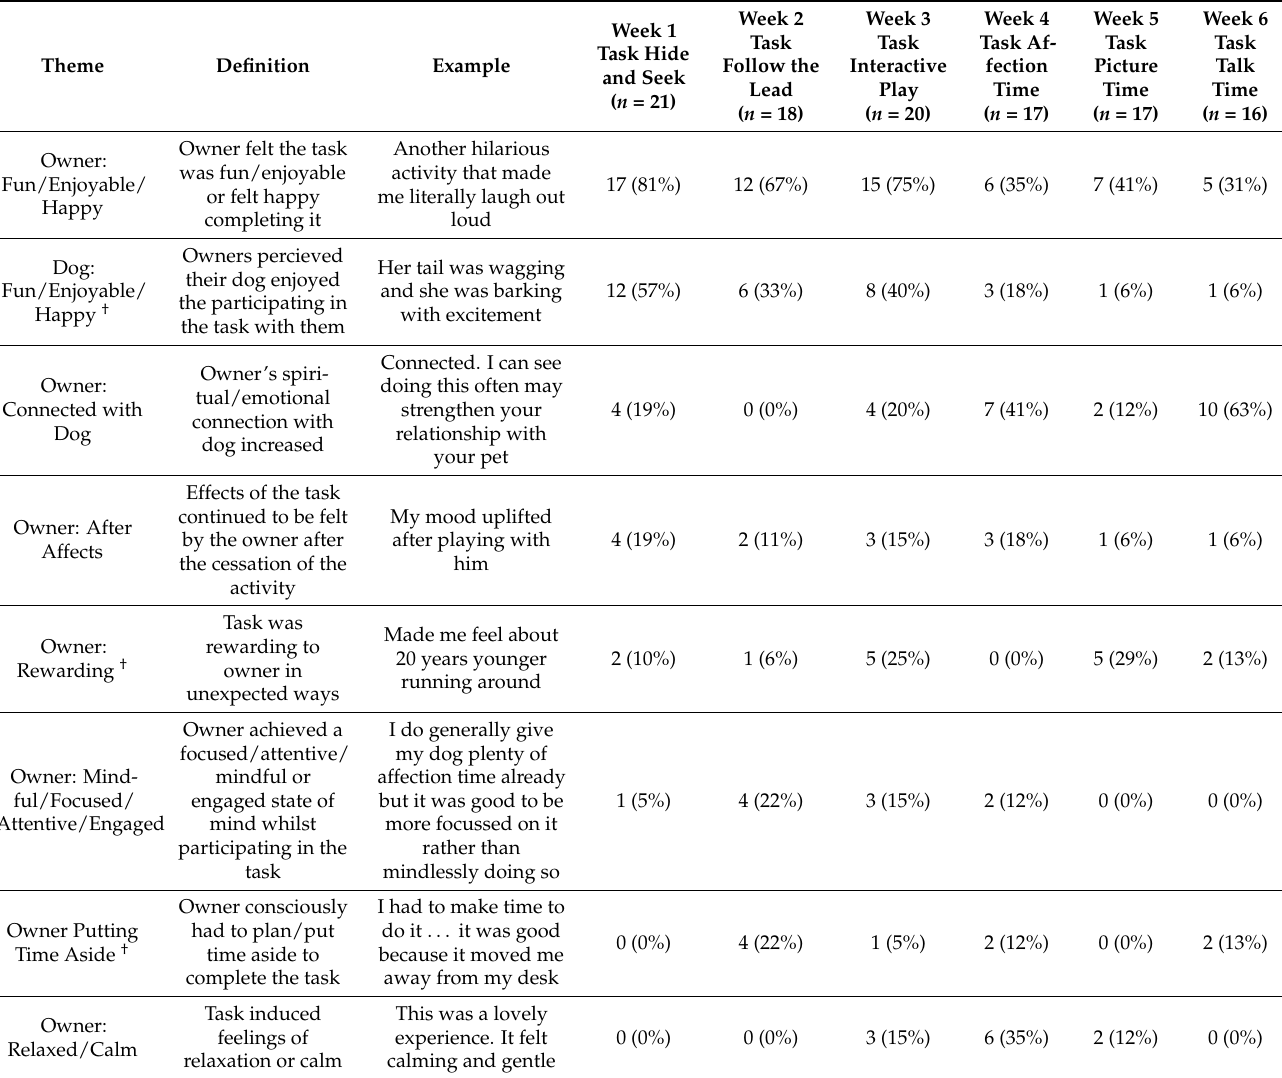
Table 8. Most frequently endorsed themes relating to the dog interaction groups weekly task